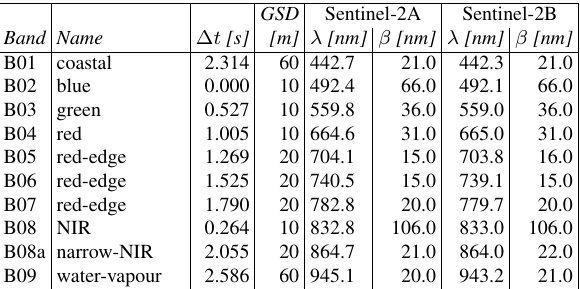
Figure 3. Focal plane assembly of Sentinel-2 Table 1. Sentinel-2 multispectral VNIR bands GSD